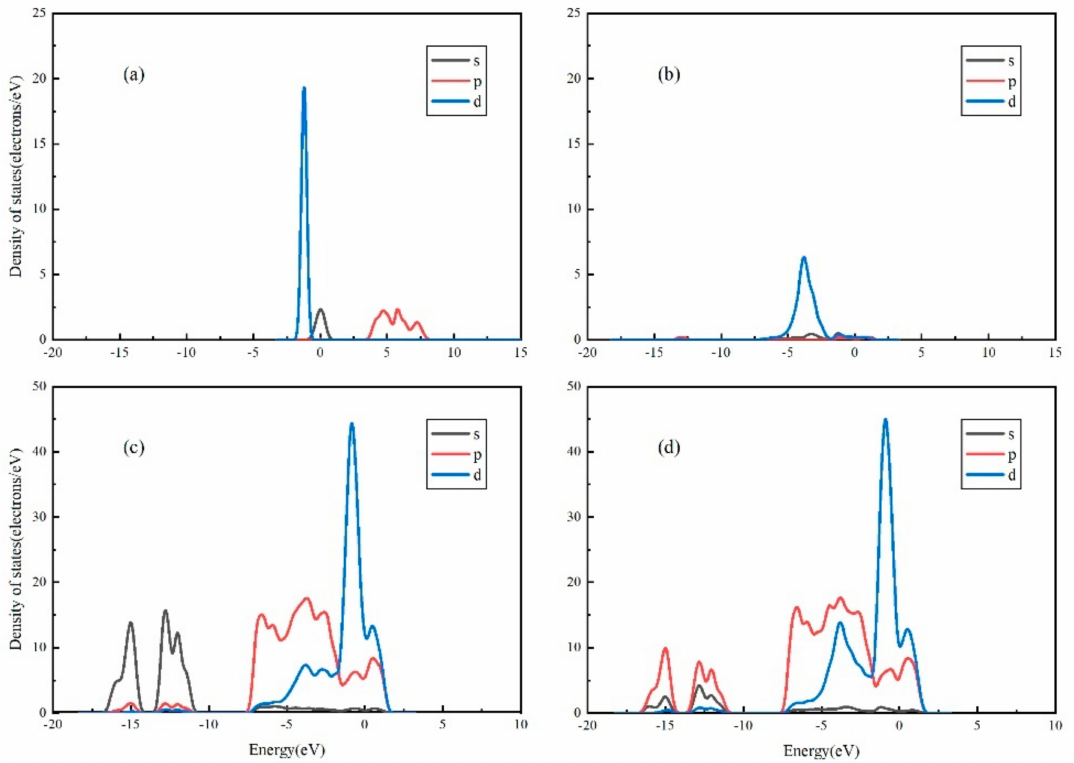
Figure 4. The PDOS plots for the Au atom and the pyrite surface atoms: ( a ) for Au before adsorption; ( b ) for Au adsorption on pyrite (210) surface; ( c ) for pyrite (210) surface before adsorption; ( d ) for pyrite (210) surface after Au is